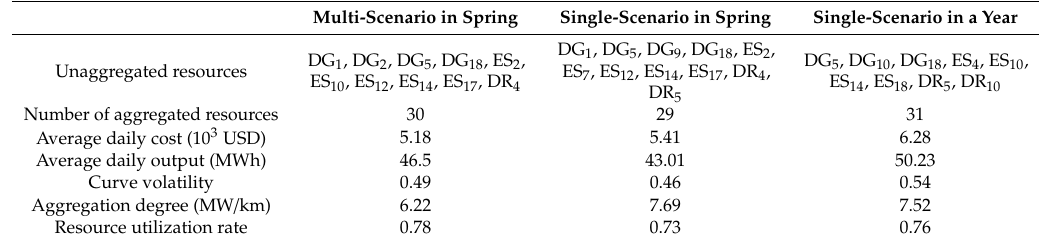
Table 6. Single-scenario aggregation